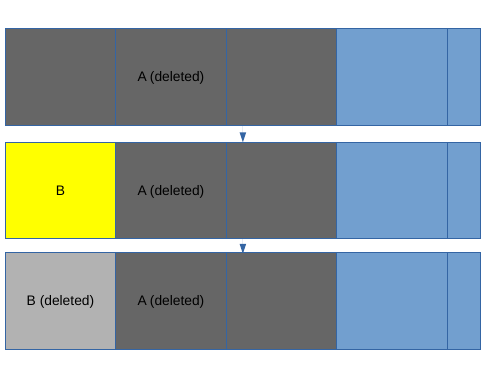
Figure 12. Test Case